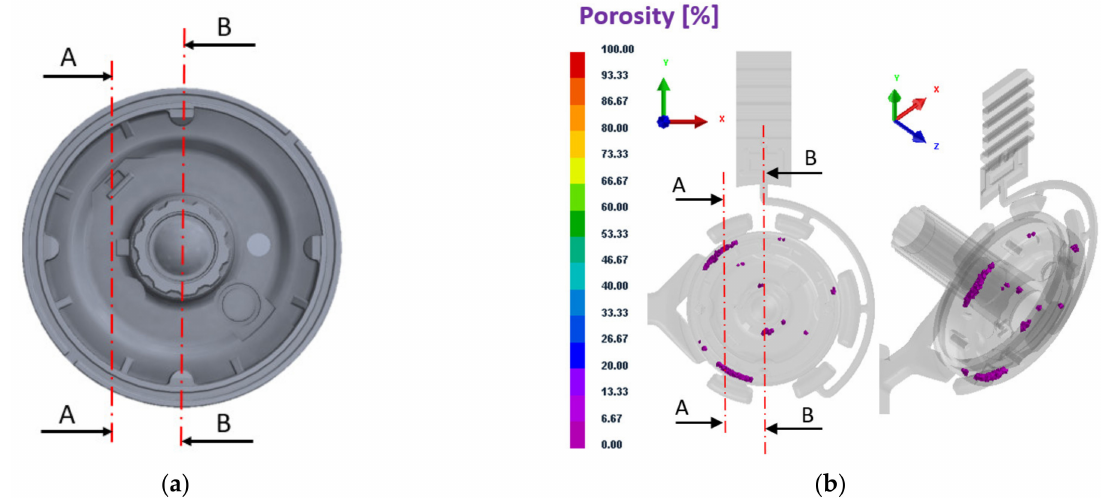
Figure 11. Checking cuts (incisions) A-A and B-B of castings on the casting at position 1: ( a ) Location of cuts within the casting; ( b ) Location of cuts with respect to porosity in the